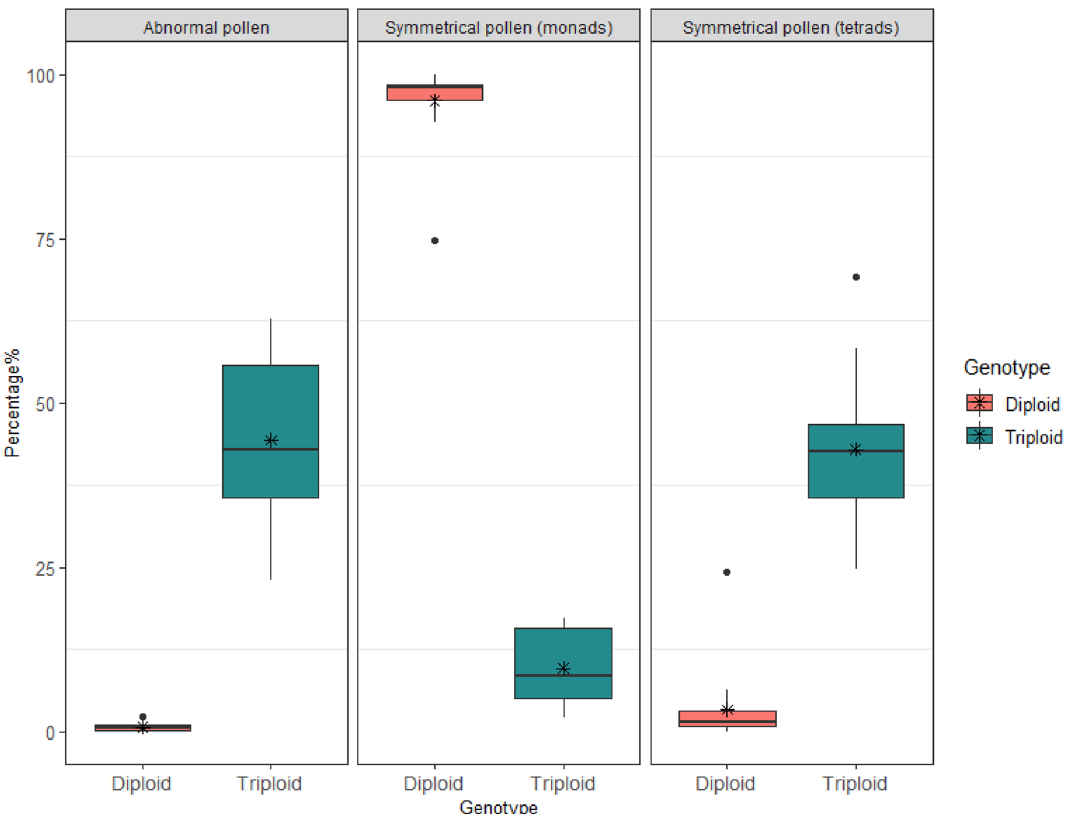
Figure 1. Comparison of pollen grain characteristics of triploid and diploid watermelon genotypes, including the percentage (per flower) of abnormal pollen, and symmetrical pollen as tetrads and monads. Each box indicates quartiles with median and points outside of the box are outliers. Mean of percentage in each genotype is marked as an asterisk (*)